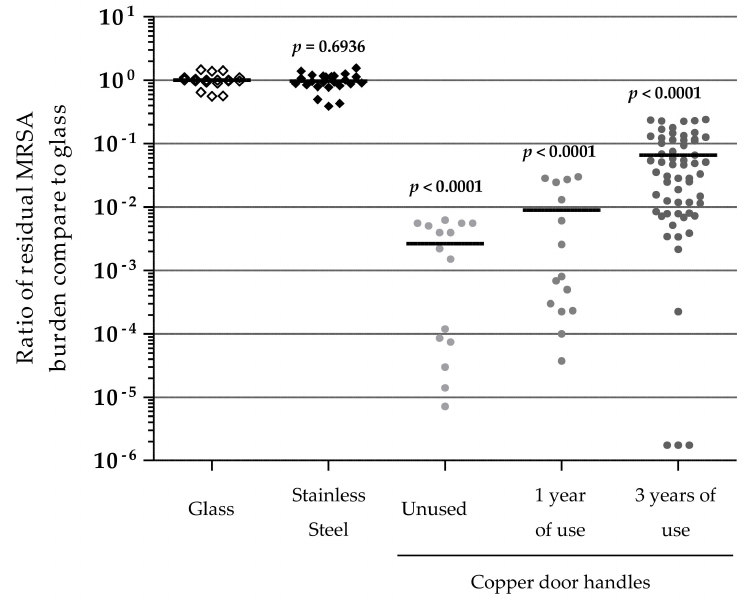
Figure 4. Residual methicillin-resistant Staphylococcus aureus (MRSA) burdens after 2 h of contact with the surfaces. The tested surfaces were stainless steel, and copper door handles after different times of use in long-term care facilities (unused, 1 year and 3 years after set-up). All the values are the ratio of the number of colony-forming units (CFU) observed on tested surfaces over the mean of CFU observed on glass as reference. Black lines represent the mean values of raw data. p -values of the comparison of each type of surface with